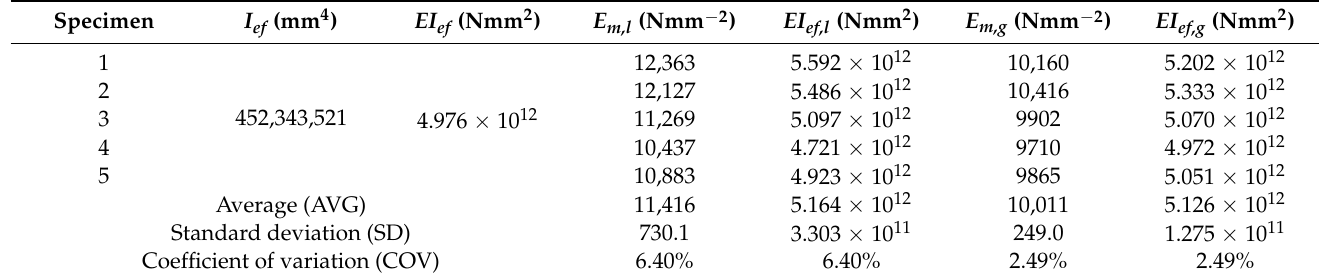
Table 5. Results of the effective moment of inertia, the moduli of elasticity and the stiffnesses in bending for CLT 160-5.